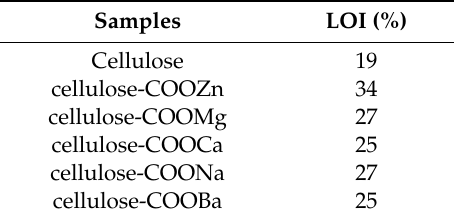
Table 3. The result of LOI of cellulose and TOC. Samples